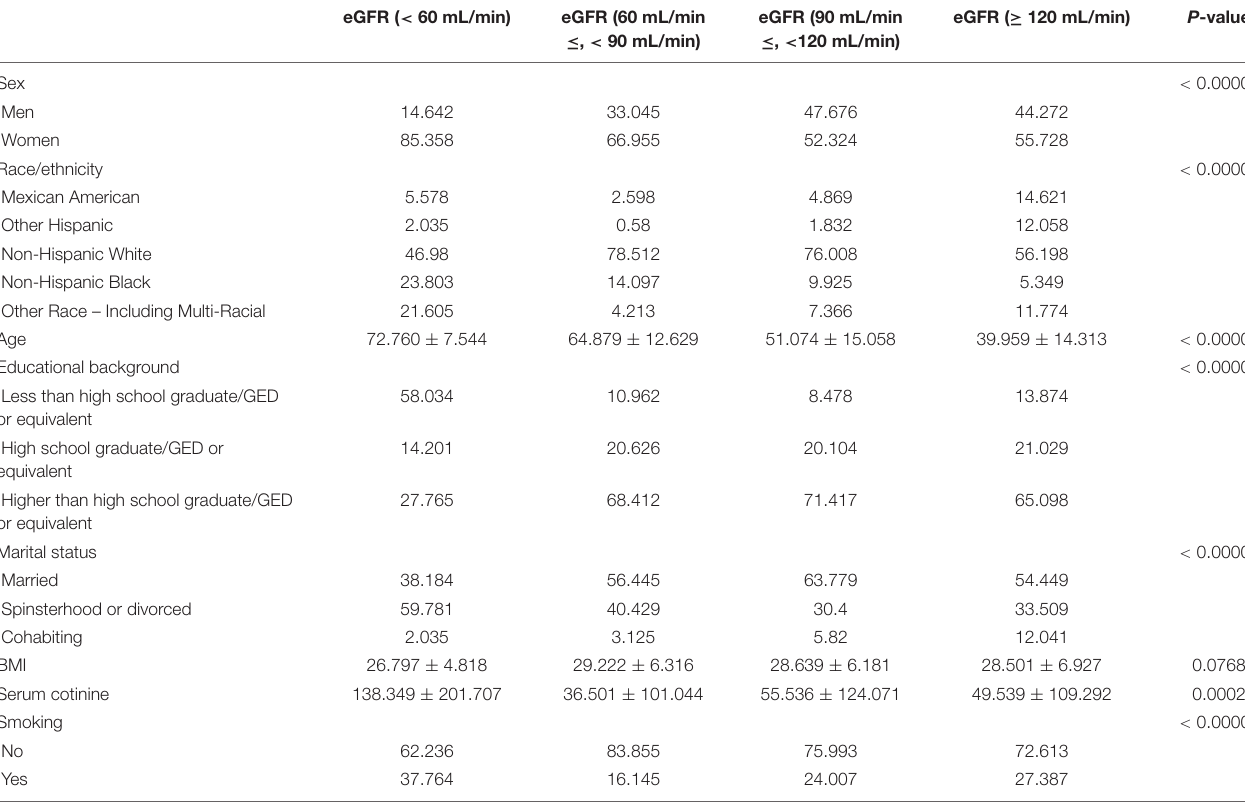
TABLE 1 | Weighted characteristics of the study population stratified based on the